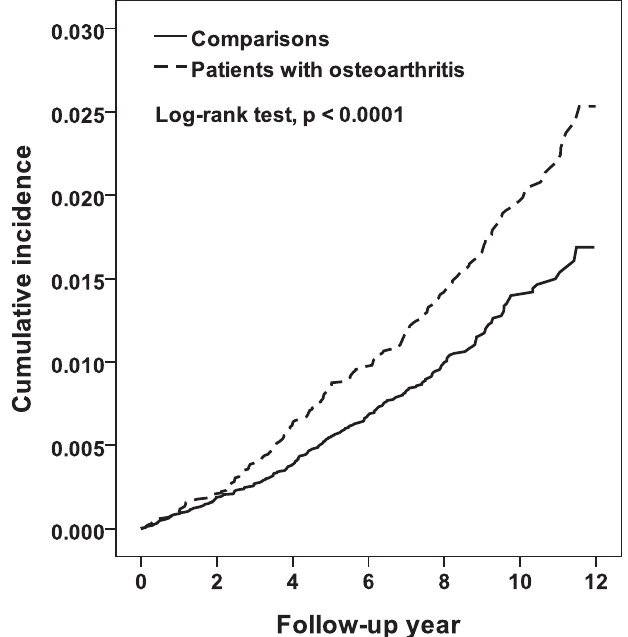
Figure 2. Cumulative incidence of stroke compared between patients with and without